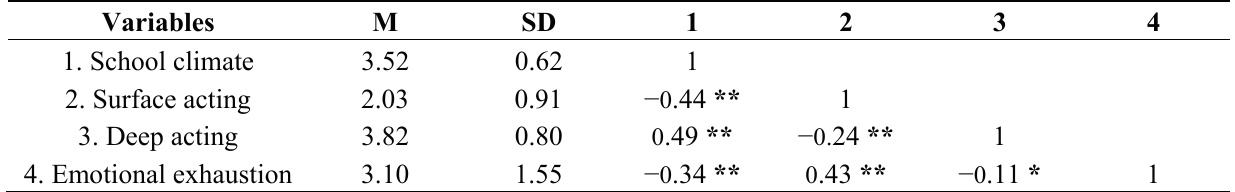
Table 1. Means, Standard Deviations and Correlations of the latent variables in this study.